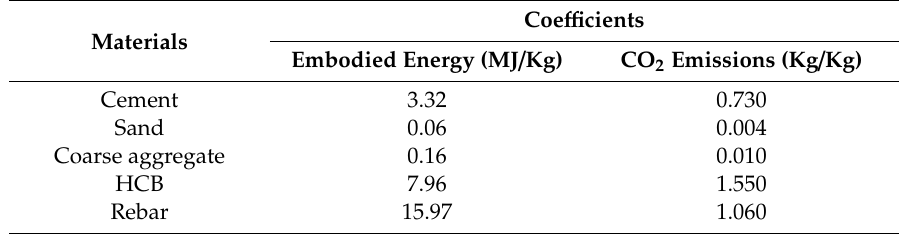
Table 2. Coe ffi cients of embodied energy and CO 2 emissions of the building materials adopted for the study [16].